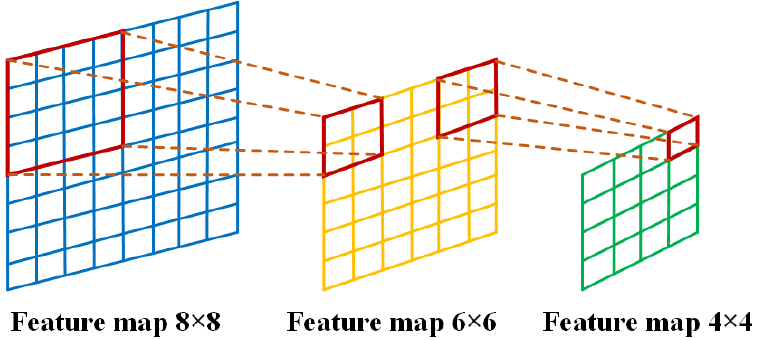
Figure 3. Schematic diagram of feature